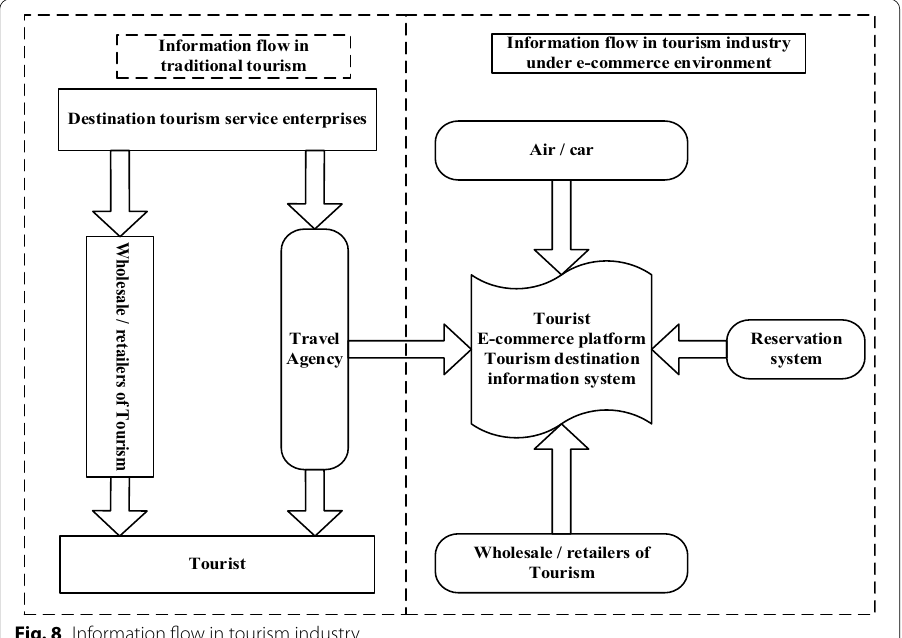
Fig. 8 Information flow in tourism